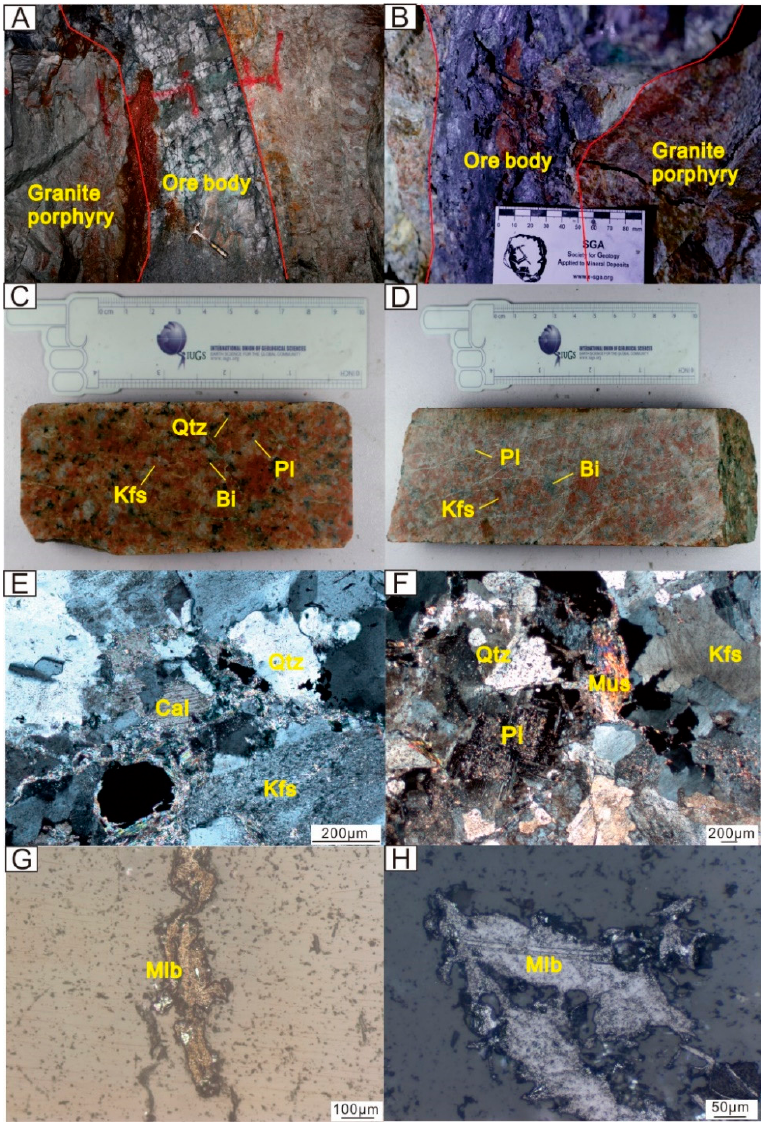
Figure 3. ( A , B ) The quartz-molybdenite veins are present in the underground tunnel of the Jiangjiatun Mo deposit; ( C , D ) the representative hand samples of granite porphyry at Jiangjiatun; ( E , F ) the essential minerals of the ore-related granite porphyry at Jiangjiatun under cross-polarized light; ( G , H ) molybdenites in the Jiangjiatun Mo deposit. Abbreviations: Mlb—molybdenite, Qtz—quartz, Pl—